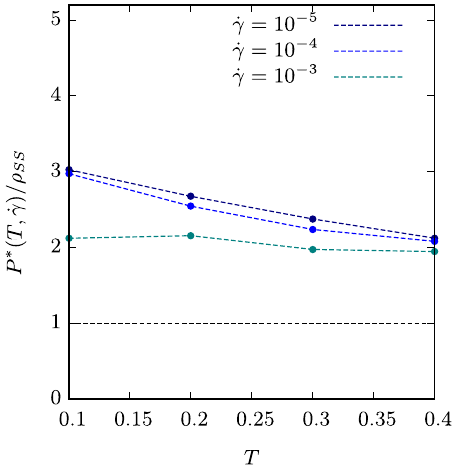
FIG. 4. The plateau probability P (cid:2) for a particle with high D 2 to reside in a soft spot, normalized by the soft-spot density, P This represents how much more likely rearrangements are to be found at soft spots than if the soft-spot map were completely uncorrelated with rearrangements. A value of 1 (dashed line) represents the uncorrelated value. The ratio is 0 when the soft- spot map is anticorrelated and so describes no plastic activity. The value of 5.2 represents the maximum possible value of P (cid:2) , 1 = ρ which occurs if all of the plastic activity resides in soft spots. Data are shown for strain rates _ γ ¼ 10 − 5 (in dark blue) to _ γ ¼ 10 − 3 (in